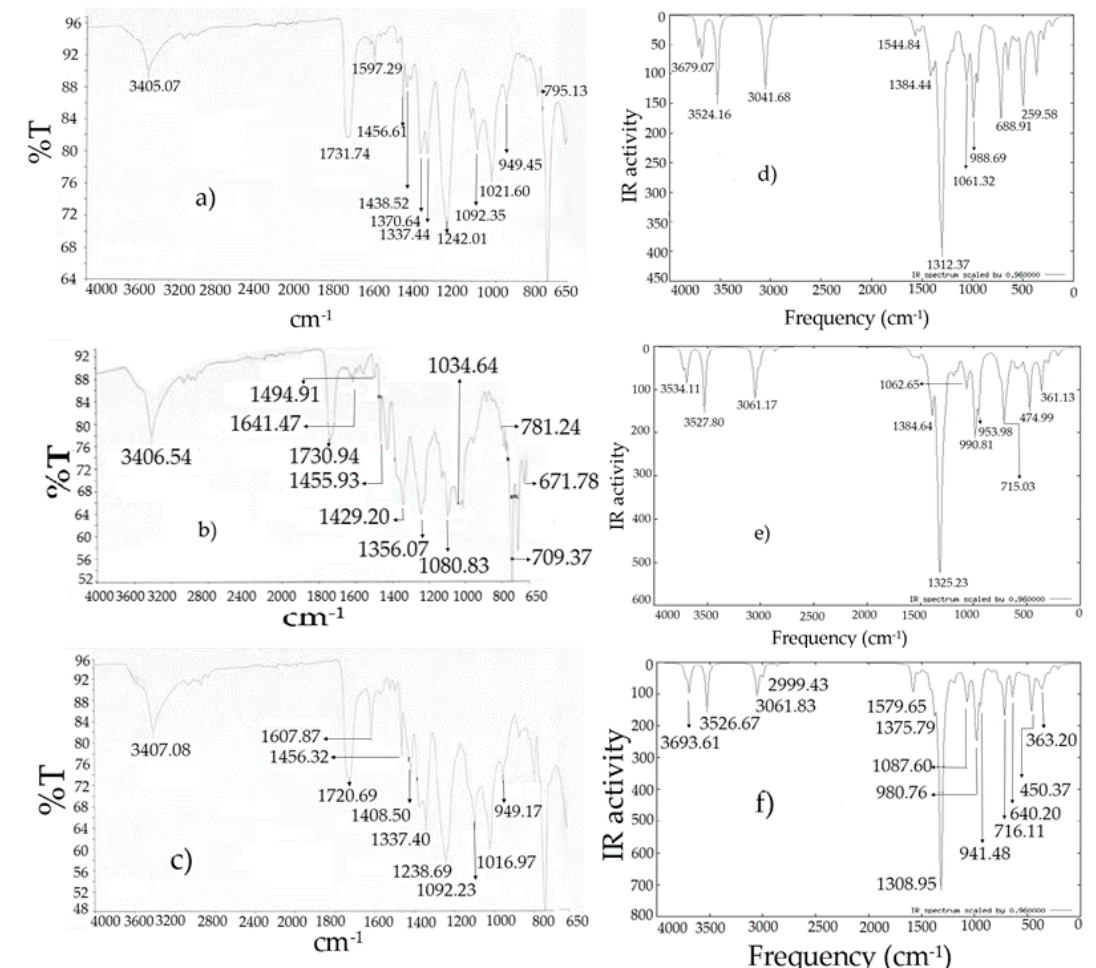
Figure 7. Infrared spectra: ( a ) I experimental [10]; ( b ) II experimental [10]; ( c ) III experimental [10]; ( d ) I theoretical; ( e ) II theoretical; ( f ) III theoretical.